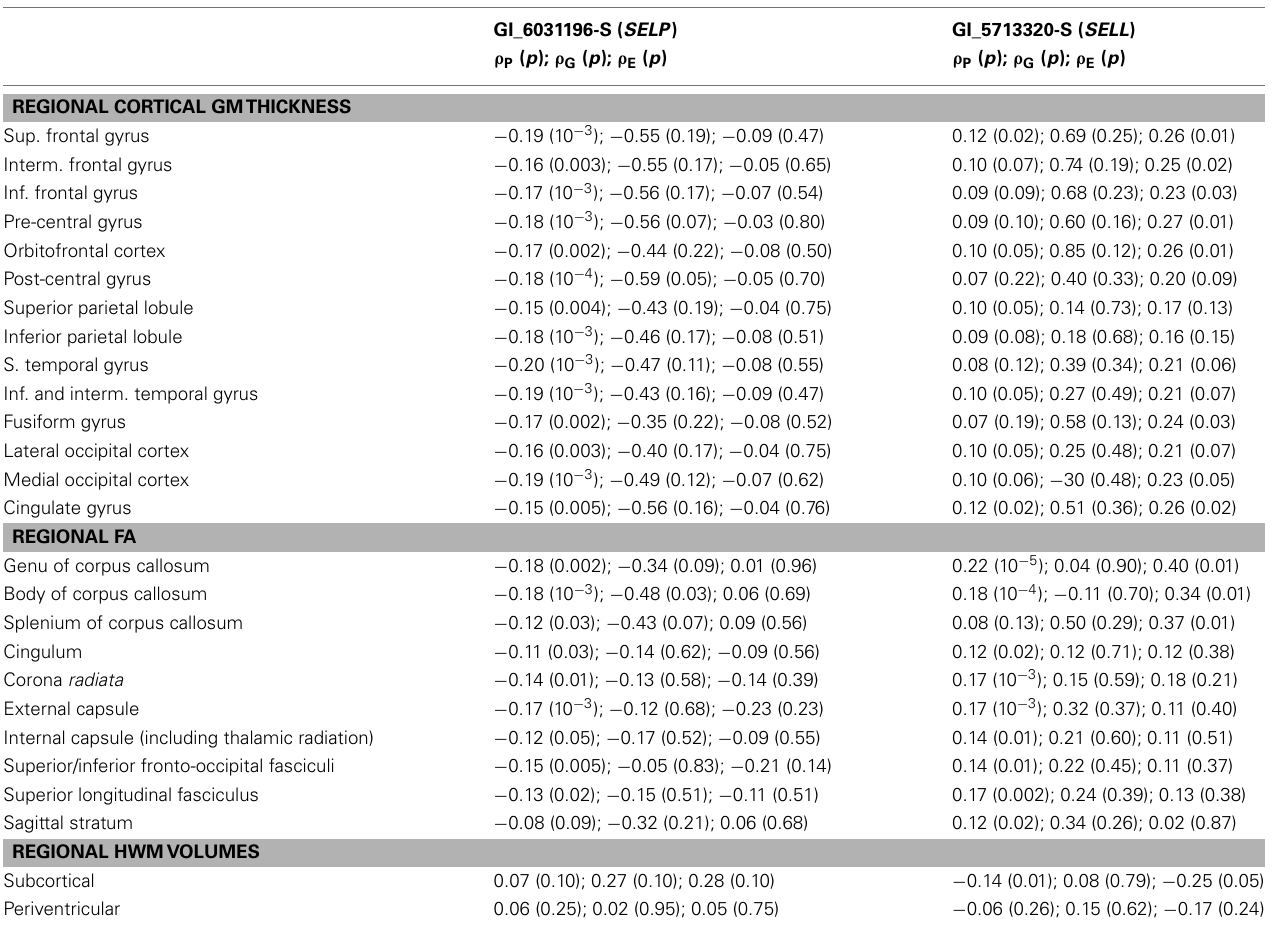
Table 4 | Results of the bivariate genetic correlation analysis for regional measurement of cerebral